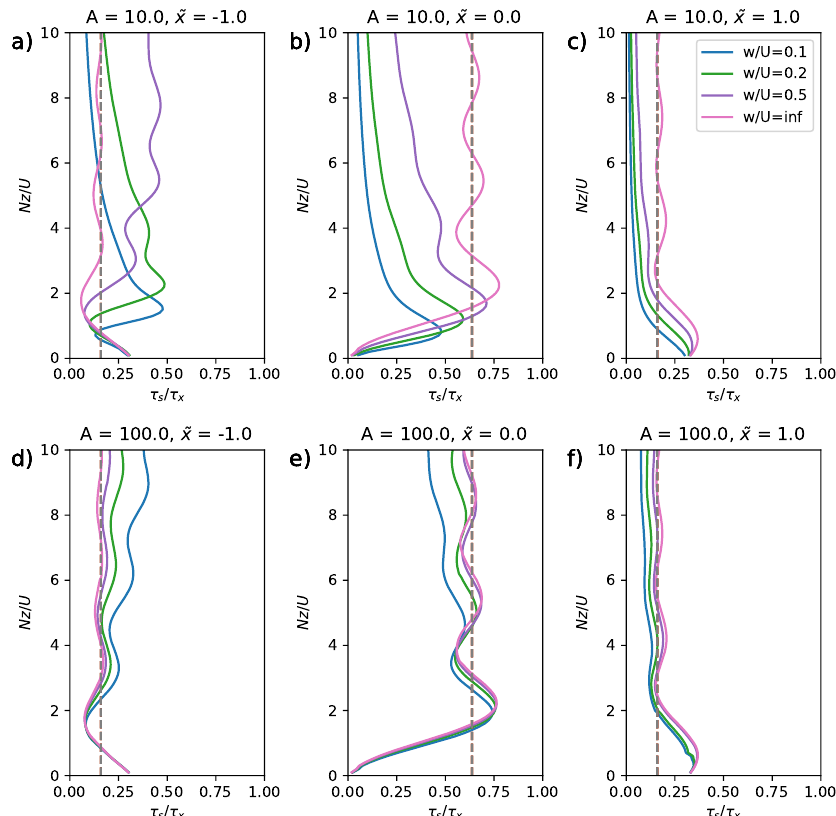
Figure 3. The along-trajectory integrated mean momentum flux, τ s , normalized by the horizontal total flux, τ x , as a function of the normalised height, z / λ z , for the Queney mountain wave solution. Subplots are for launch locations ˜ x = − 1 ( a , d ) , ˜ x = 0 ( b , e ), ˜ x = 1 ( c , f ), and for A = 10 ( a – c ) and A = 100 ( d – f ). In each subplot, results are shown for a range of non-dimensional ascent rates, W/U, of 0.1, 0.2, 0.5, and ∞ (a vertical profile). The dotted vertical line shows the asymptotic correction factor 2/ ( π ( 1 + ˜ x 2 ) 2 ) for a vertical profile in each